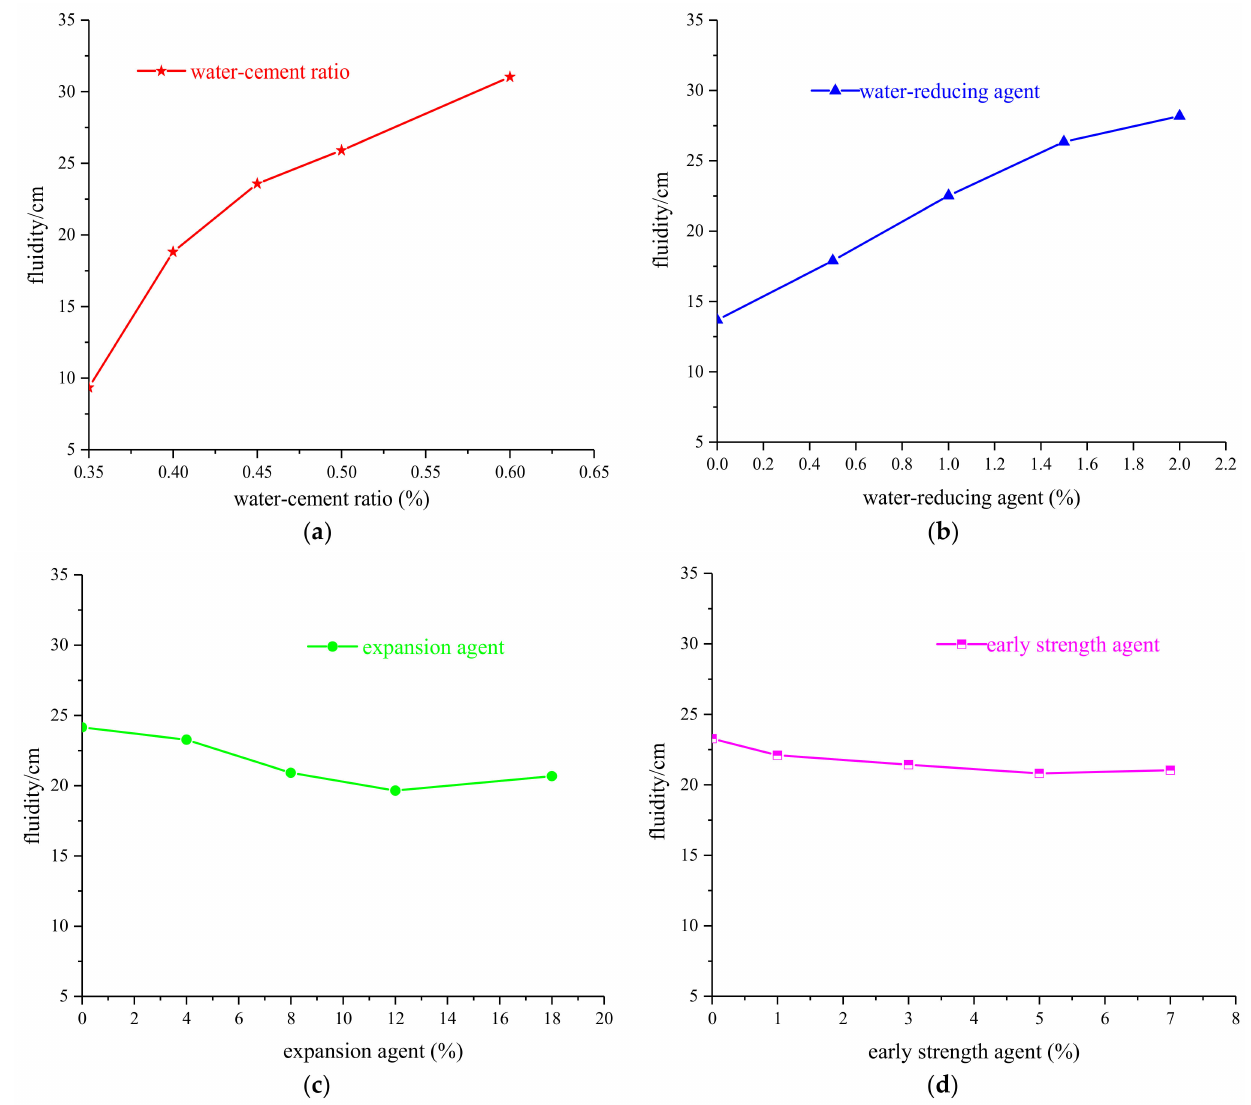
Figure 4. The influence of various factors on the development trend of fluidity. ( a ) Influence of water–cement ratio on fluidity; ( b ) influence of water-reducing agent on fluidity; ( c ) influence of expansion agent on fluidity; ( d ) influence of early-strength agent on